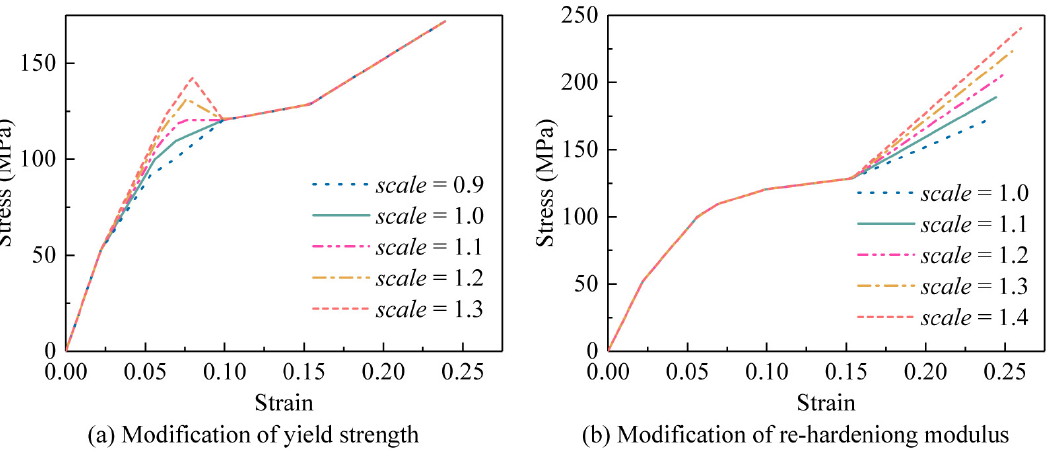
Figure 18. Stress–strain curve of primer at 5 s − 1 . ( a ) Modification of yield strength. scale is the ratio of modified yield strength to its initial value. ( b ) Modification of re-hardening modulus. scale is the scale factor of the 6th value of yield stress in Table 4.